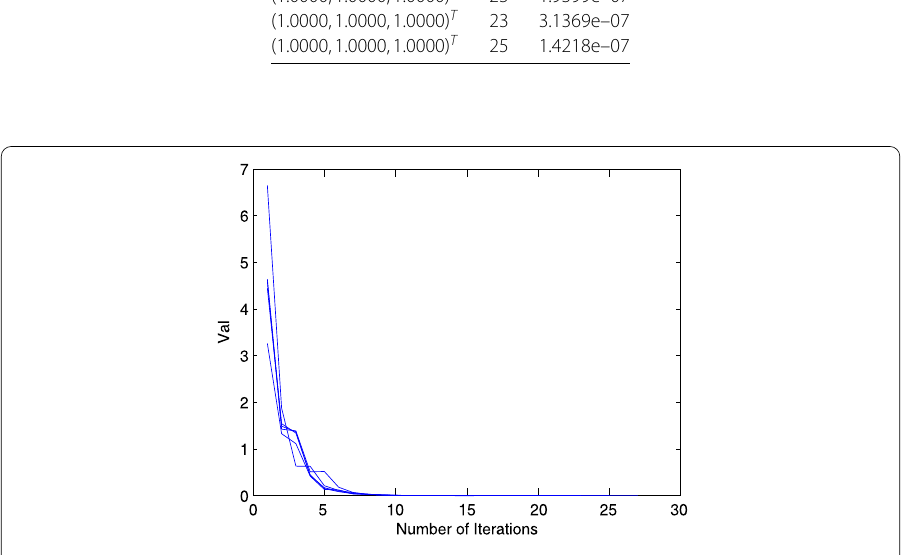
Figure 1 Numerical results for Example